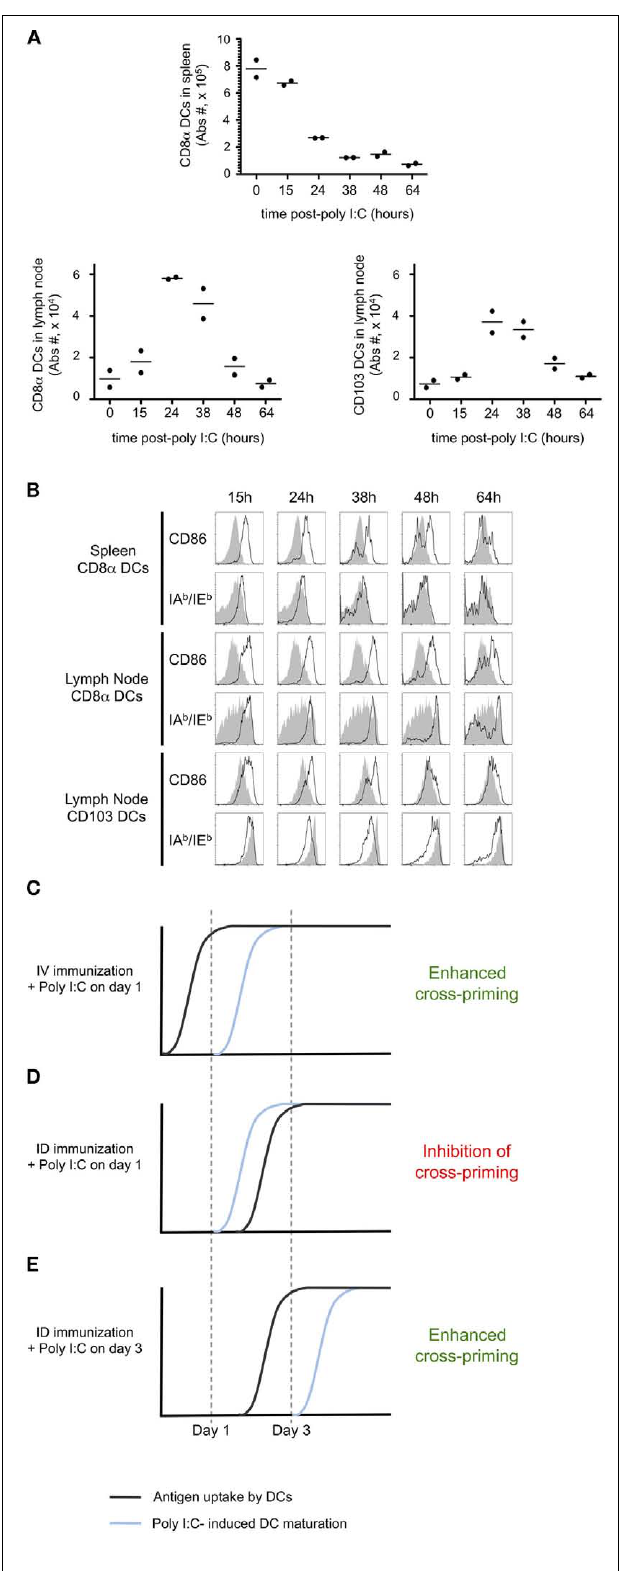
FIGURE 8 | Poly I:C induces rapid DC maturation. Mice were injected i.v. with 100 μ g of Poly I:C. At defined time points, the spleen and a lymph node were harvested.The total numbers of CD8 α + DCs and CD103 + DCs per organ (A) and the expression of CD86 and IA b /IE b (B) were determined. In (B) the gray histograms indicate the level of expression in untreated animals and the black line corresponds to poly I:C-injected mice. (C–E) Proposed model to explain the different effects of Poly I:C depending on the timing of delivery.The proposed timing of antigen uptake (black line) and the kinetic of DC maturation upon Poly I:C injection (blue line) are represented for three different